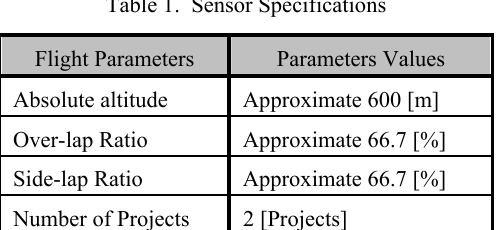
Table 1. Sensor Specifications